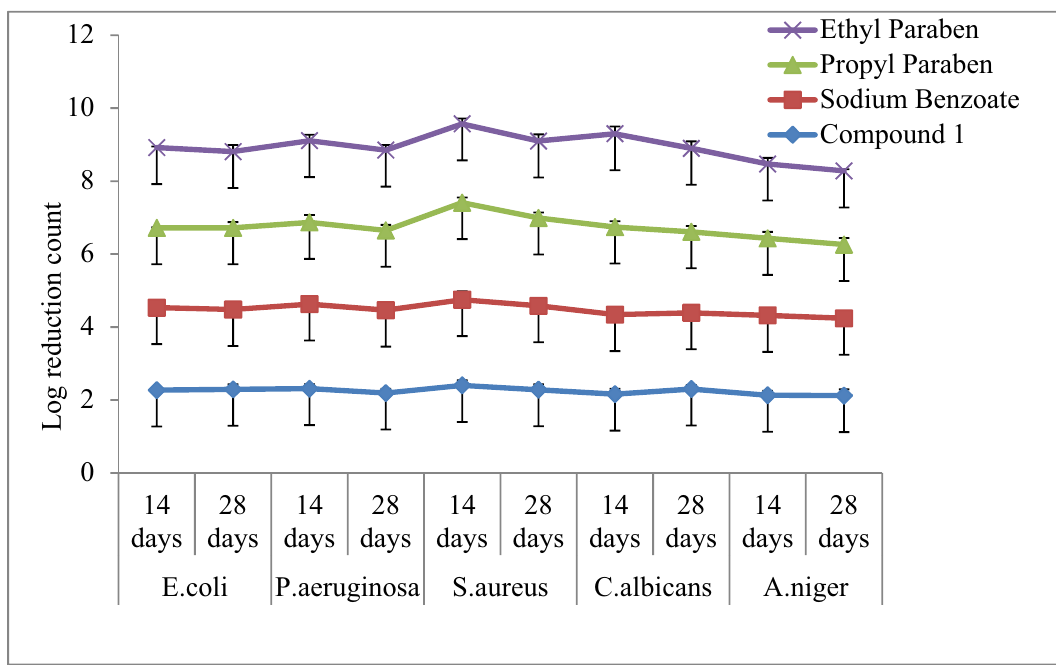
Figure 3. Preservative efficacy results of compound 1 in Aloe vera juice and degree of microbial log reduction. Data are means of five replicates; standard deviation is shown as error bars. Chart indicates statistically significant differences between groups (p <